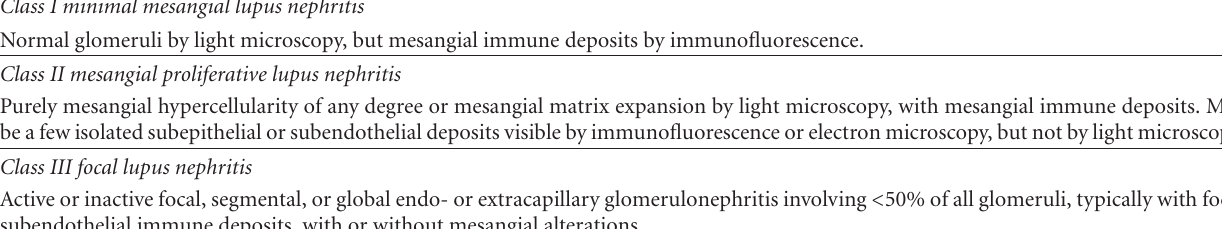
Table 2: International Society of Nephrology/Renal Pathology Society (ISN/RPS) 2003 classification of LN [175]. Class I minimal mesangial lupus